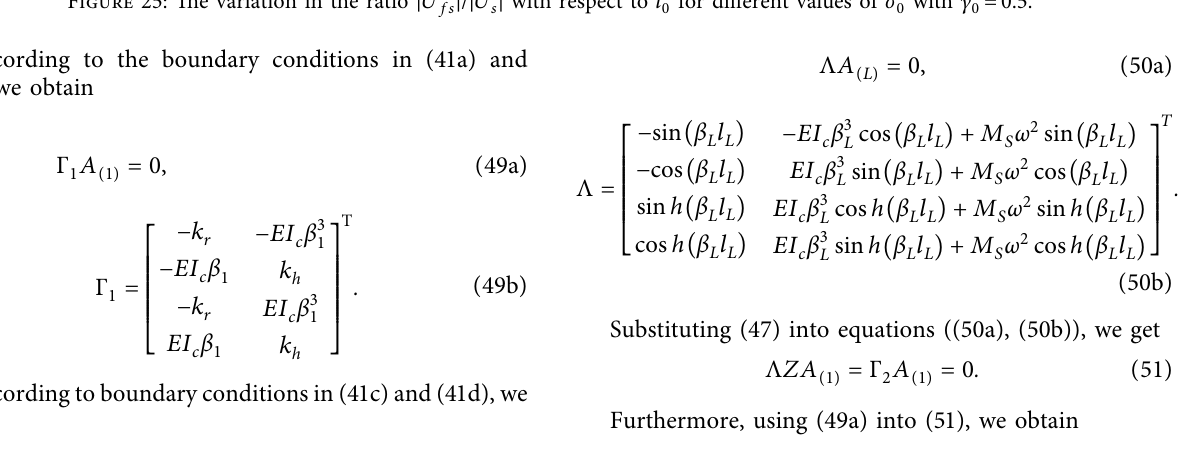
Figure 25: The variation in the ratio | U